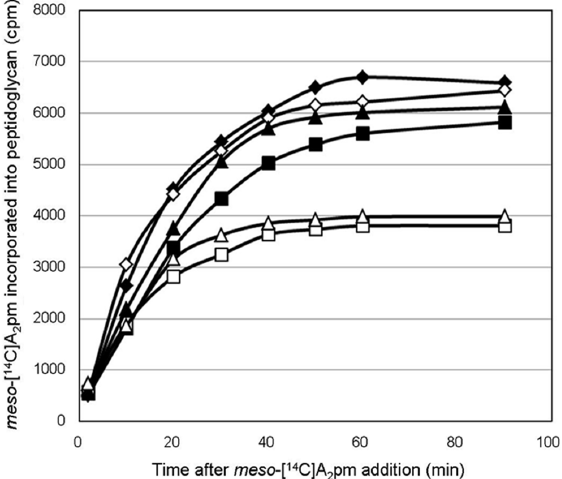
Figure 5. Effect of the periplasmic expression of wild-type and mutant forms of PcaM1 on meso -[ 14 C]A 2 pm incorporation into peptidoglycan. Cells were grown in M63-glucose minimum medium supplemented with lysine, threonine and methionine. When the OD 600 reached 0.2, anhydrotetracycline was added, or not, and meso -[ 14 C]A 2 pm was added 10 min thereafter. The incorporation of radioactivity into the peptidoglycan (trichloroacetic acid (TCA)-insoluble material) was then followed as described in the text. Symbols: diamonds, strain carrying the pASK-IBA4 empty vector; squares and triangles, strains expressing the wild-type and D222A mutant PcaM1, respectively. Open and closed symbols represent cultures treated or not with anhydrotetracycline, respectively.